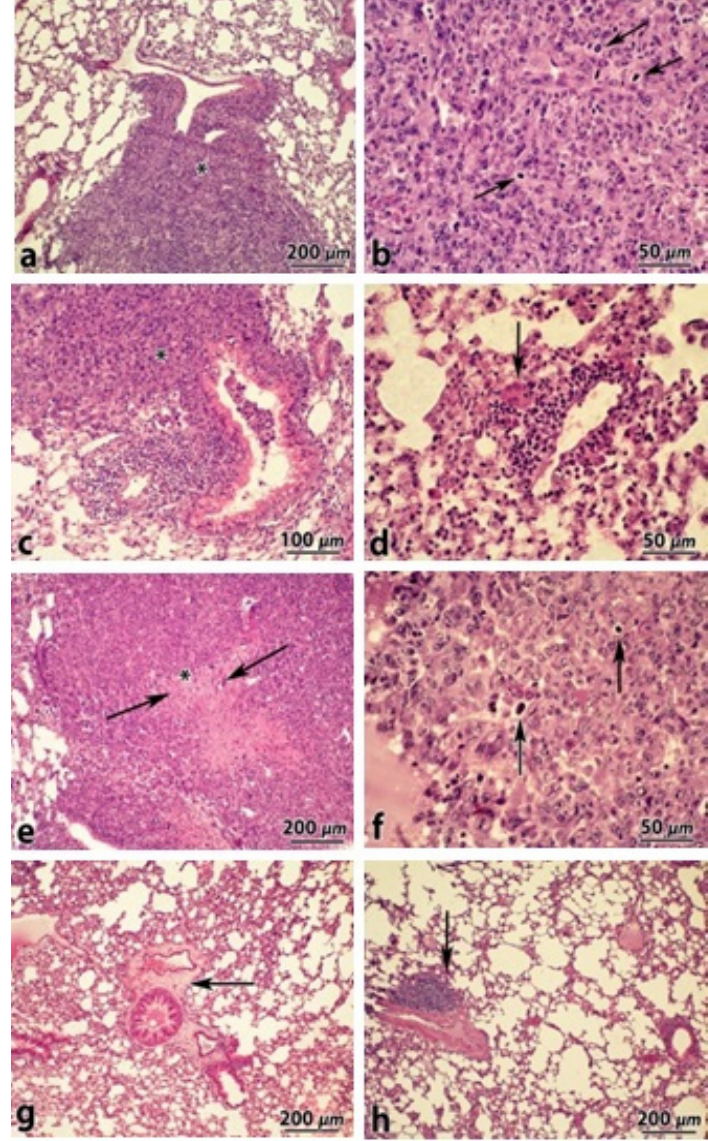
Figure 6. Histological examinations of H&E stained lung tissues sections from the mice of control ( a , b ), C 60 —( c , d ), Ber—( e , f ), and C 60 -Ber nanocomplex—( g , h ) treated groups. Arrows indicate metastatic nodules (in d – f ) and lymphoid infiltrates (in g , h ).